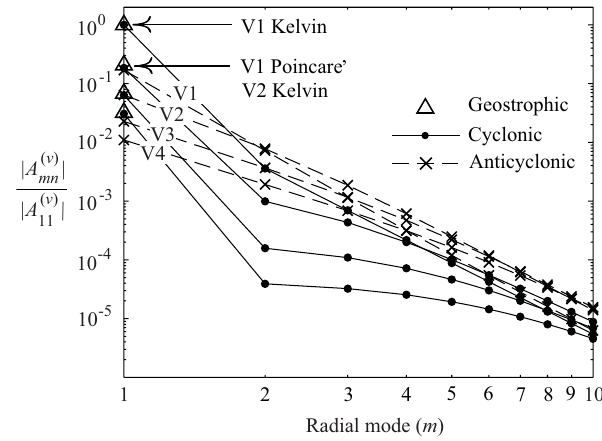
Fig. 1. Fundamental periods normalized by the inertial period T i for B = 2, h 2 = 1 and h 3 = 2.